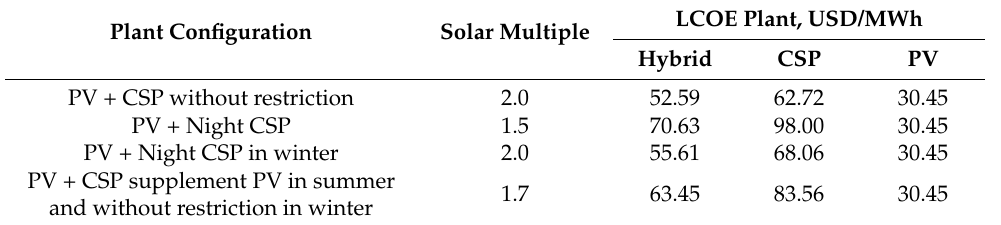
Table 10. Economic results for the CSP plant with 13 h of storage.